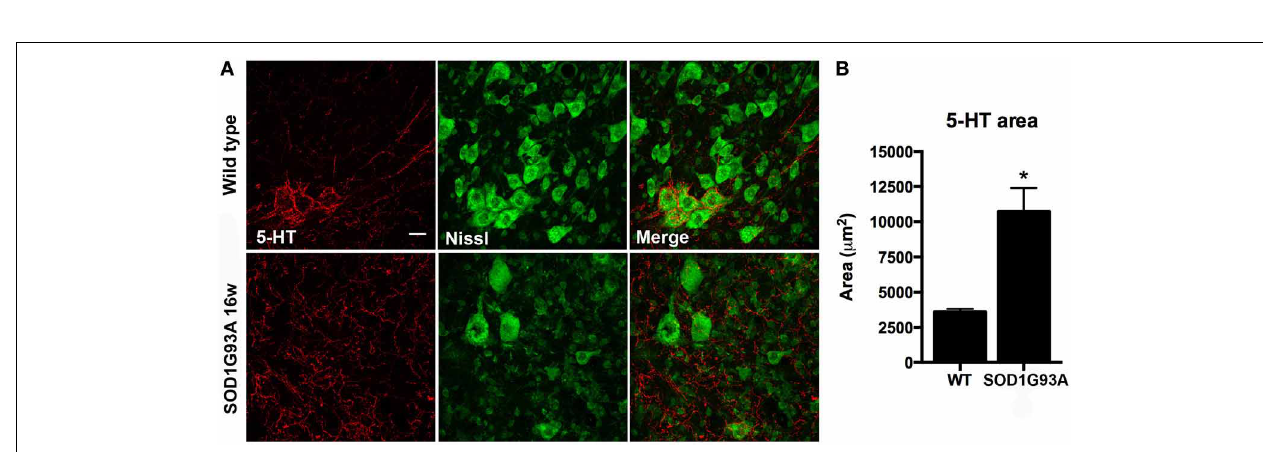
quantification revealed a progressive increase of microglial reactivity during disease progression in SOD1 G93A mice. At late stages (16 weeks of age), Iba-1 immunoreactivity level is similar to that observed in SCI and sciatic nerve injured animals. Values are mean ± s.e.m. ∗ p < 0 . 05, ∗∗ p < 0 . 01, ∗∗∗ p < 0 . 001 vs. respective wild type/naïve animals.